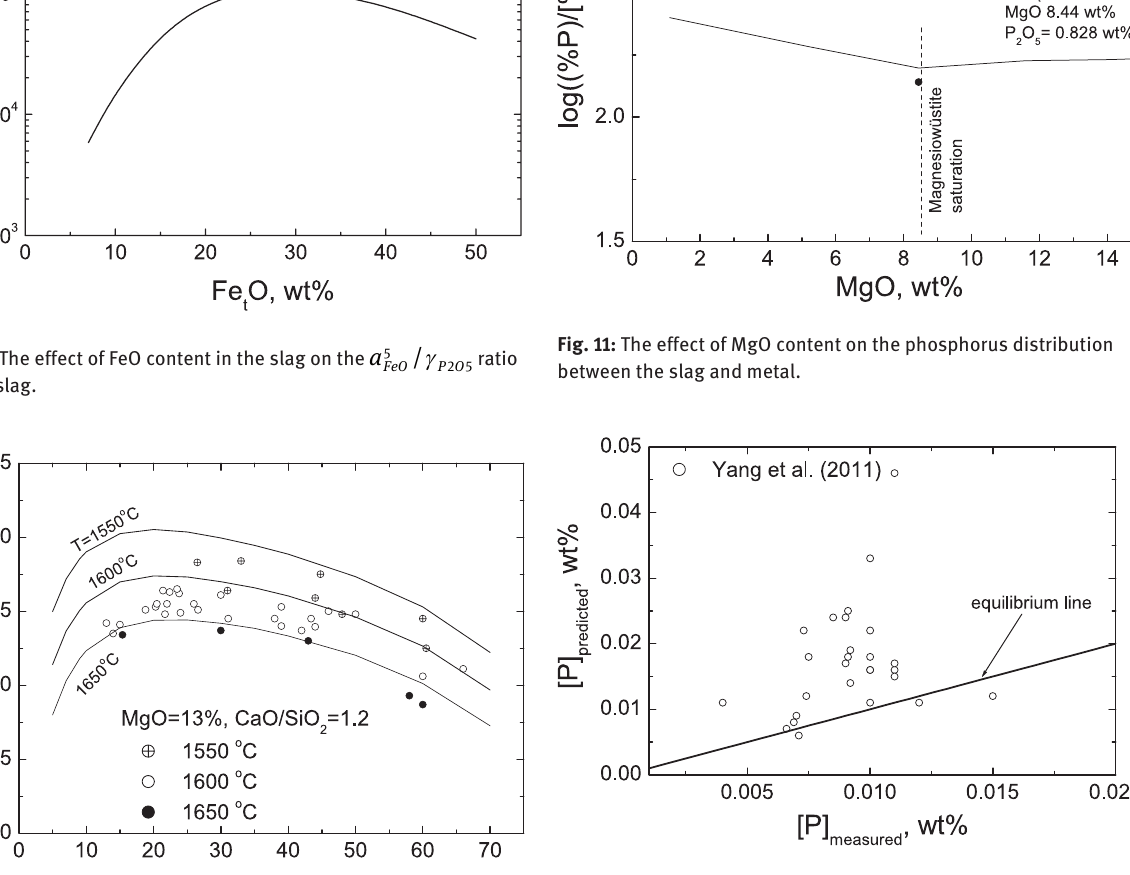
Fig. 12: The comparison of the model calculated and plant measured P content in the metal